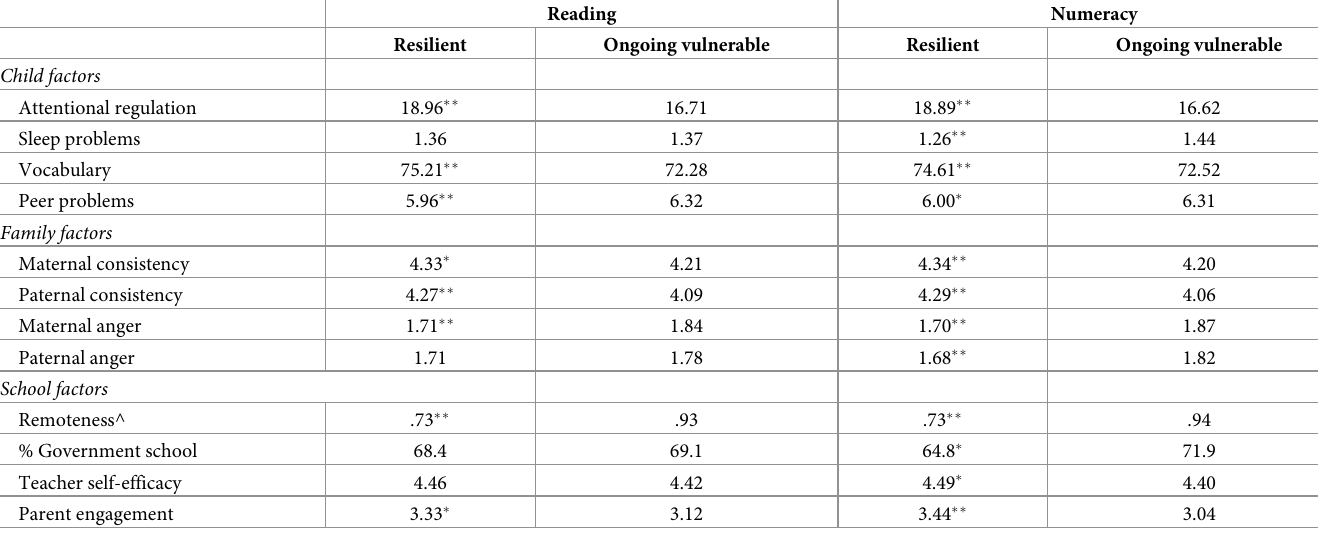
Table 4. Significant between-group differences on mean scores between resilient and ongoing vulnerable groups on explanatory variables.